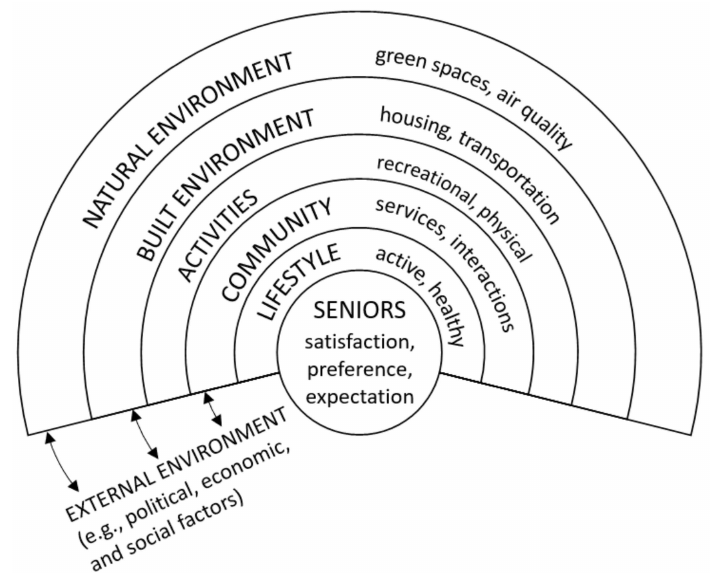
Figure 2. Senior housing ecosystem (adapted from Barton and Grant